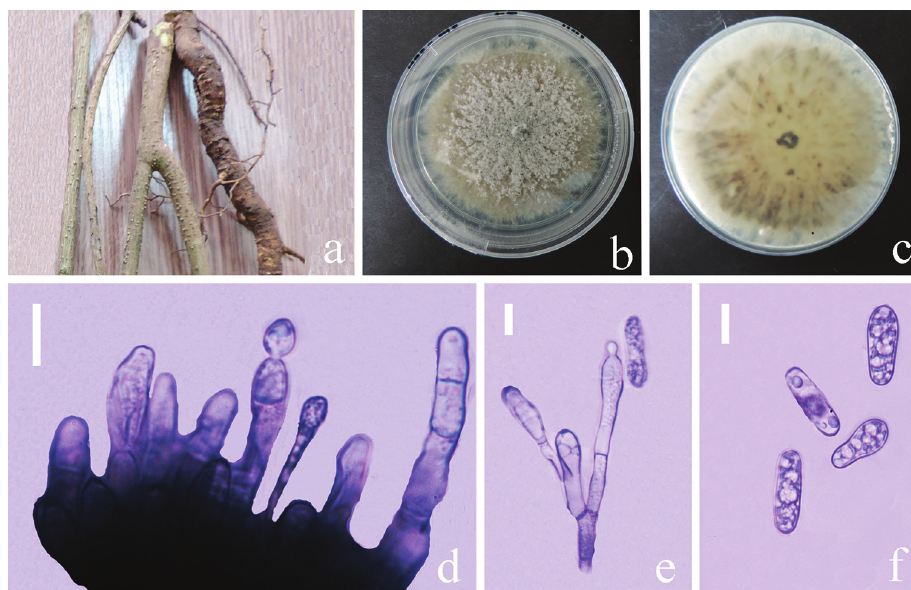
Figure 2. Colletotrichum jishouense (GACP GZU_HJ2_G3, holotype) a stems and roots of Nothapodytes pittosporoides b,c colonies on PDA d conidiophores in cotton blue e conidiophores with conidia in cotton blue f conidia in cotton blue. Scale bars: 10 µm ( d ), 5 µm ( e, f